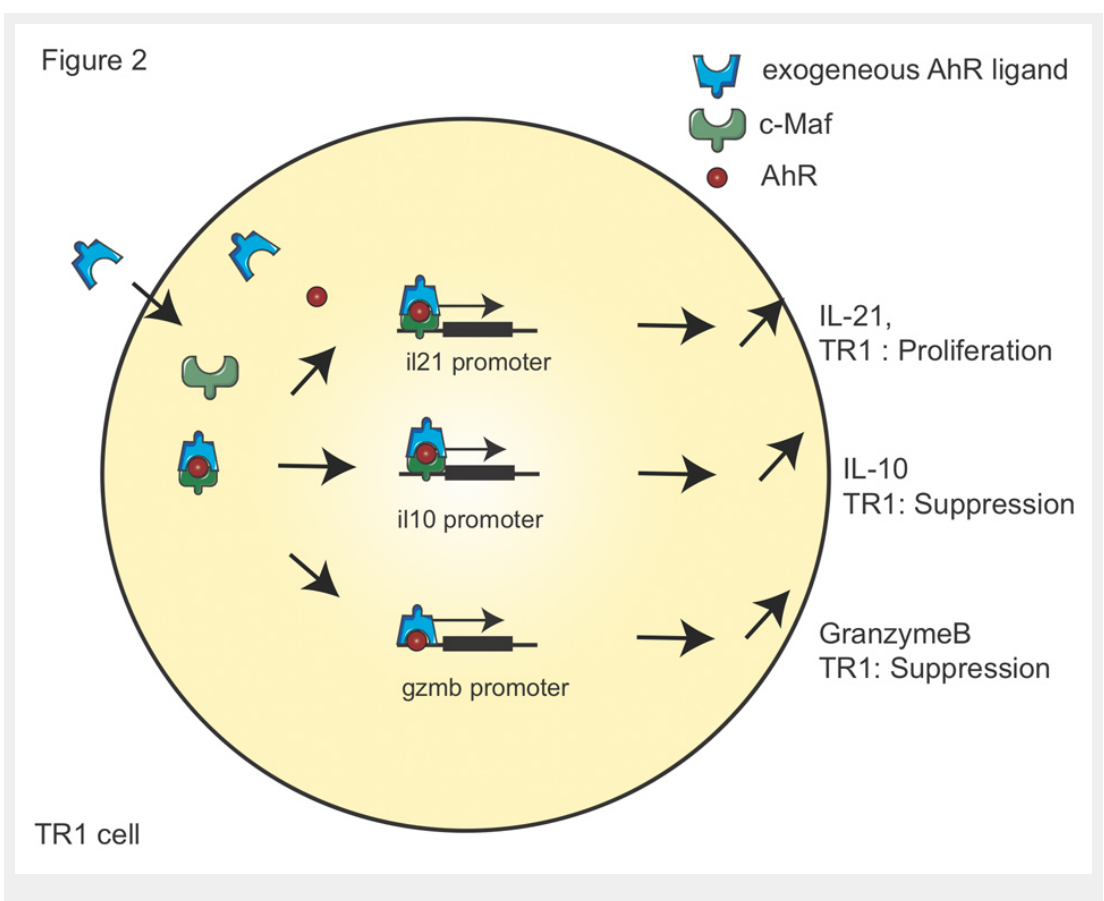
Figure 2 AhR signalling in Tr1 cells. The molecular mechanisms by which AhR promotes Tr1 cell differentiation are shown. Firstly, AhR ligands bind to AhR and transactivates il21 promoter with c-Maf that promotes Tr1 cell proliferation. Secondly, the same complex of AhR and c-Maf transactivates il10 promoter and mediates Tr1 cell suppressive function. Thirdly, AhR drives the transactivation of Gzmb promoter that promotes granzyme B expression, which contributes to the suppressive activity of Tr1